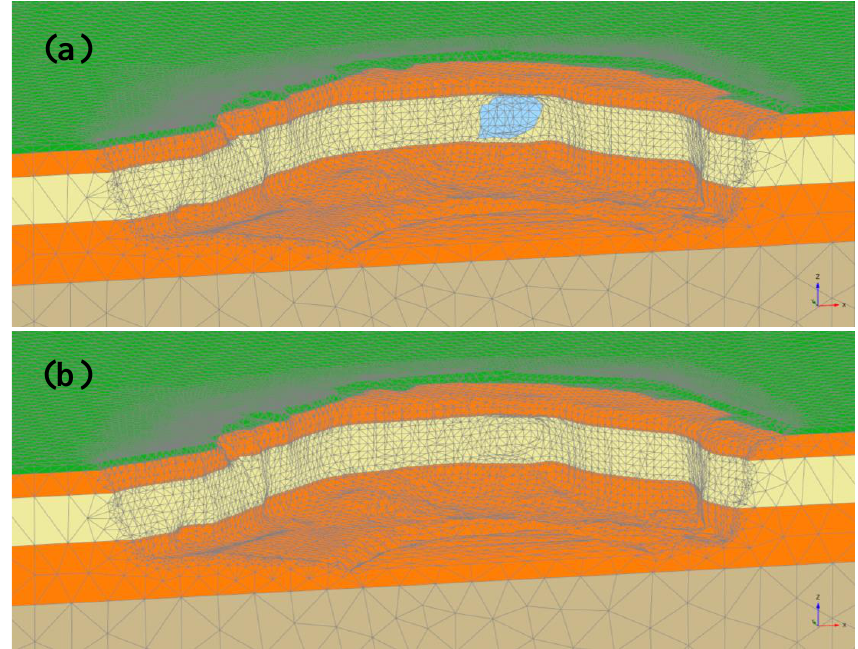
Figure 7. Three-dimensional (3D) Fem discretization meshes: ( a ) Pre- and ( b ) post- rock block Figure7. Three-dimensional(3D)Femdiscretizationmeshes: ( a ) Pre- and( b ) post- detachment.